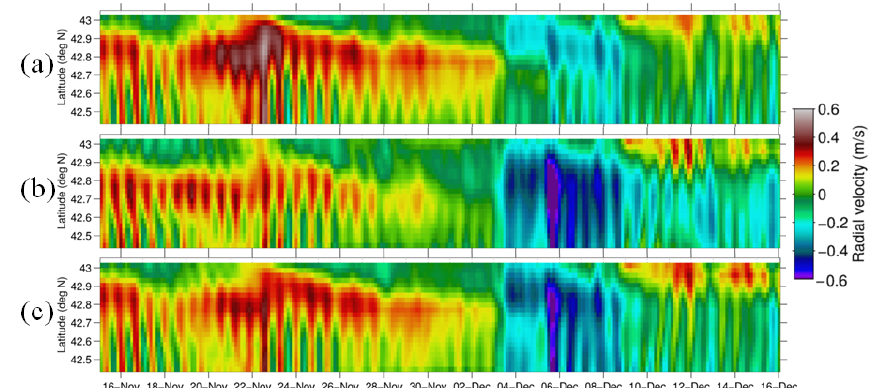
Figure 7. Hovmöller diagram of radial velocities from PEY along the south–north transect at 6.2 ◦ N (see Fig. 1), simulated by (a) the free simulation, (b) the control and (c) the analysis for WindTE simulation.